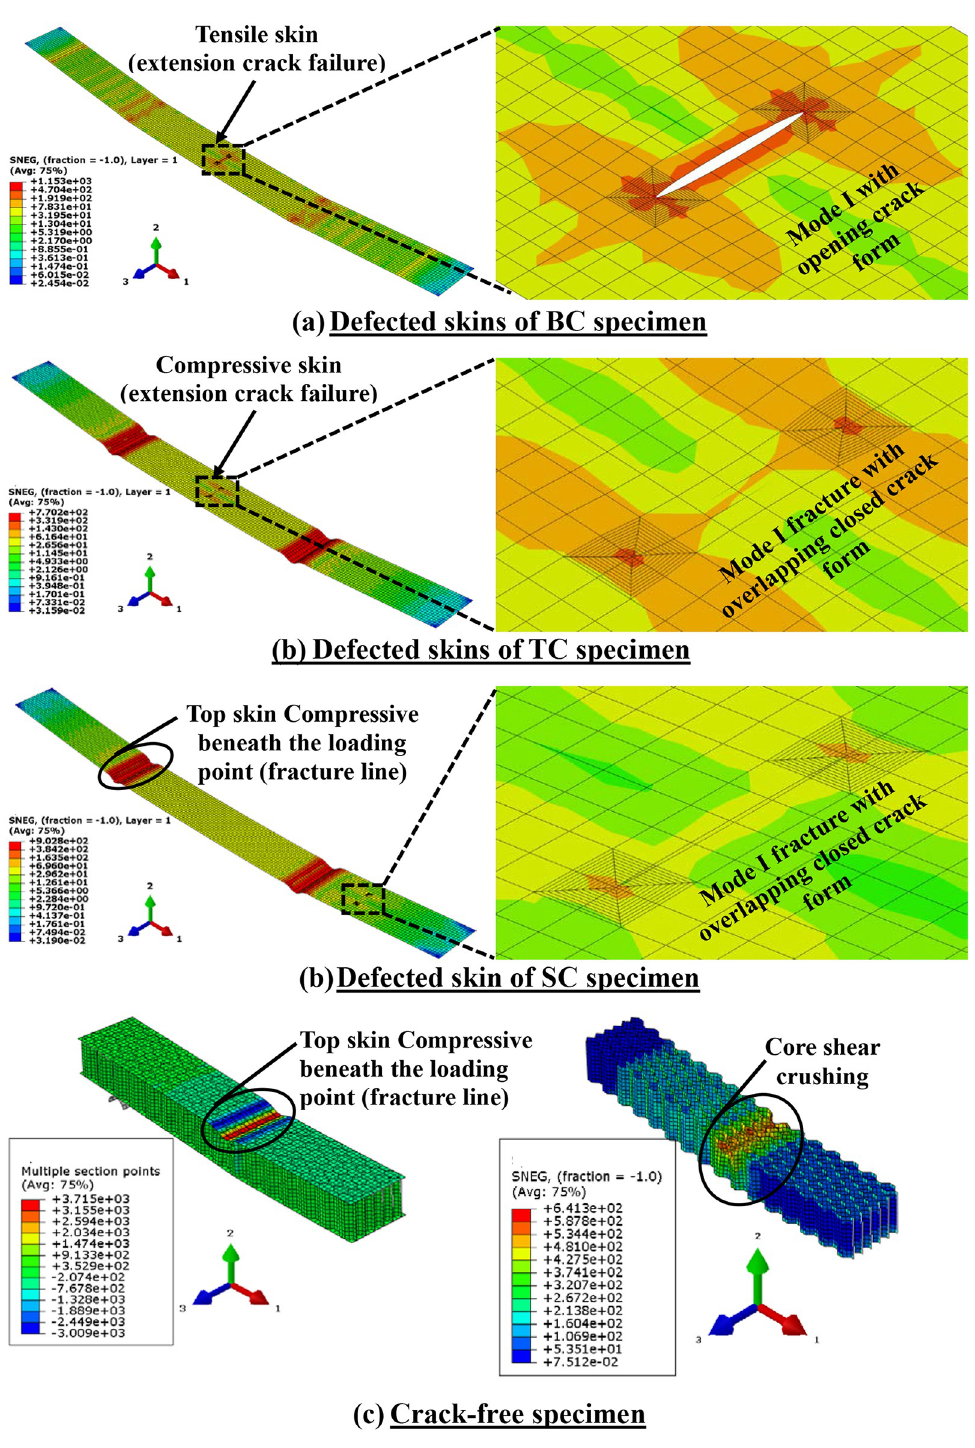
Fig 11. Oblique views of the deformed shape and stress distribution by FE modeling which indicating the failure modes of the specimens.